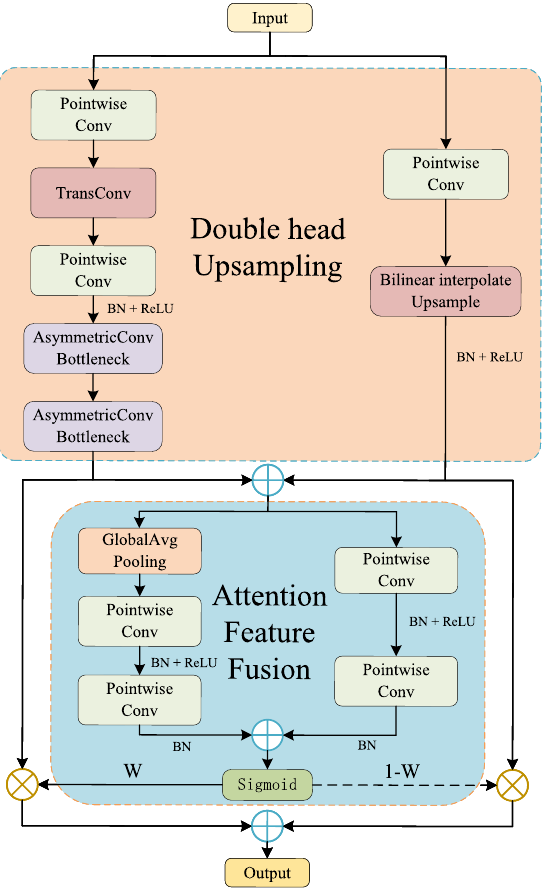
Figure 4. Double-headed Attention Feature Fusion Up-sampling module. DAFU combines the advantages of interpolation coarse up-sampling and transpose convolution fine up-sampling through attention feature fusion method, and recovers the down-sampled feature map to 2 ×